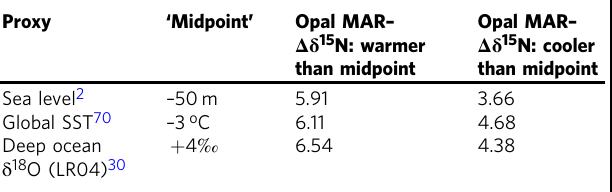
Table 1 Average nutrient upwelling for glacial and interglacial